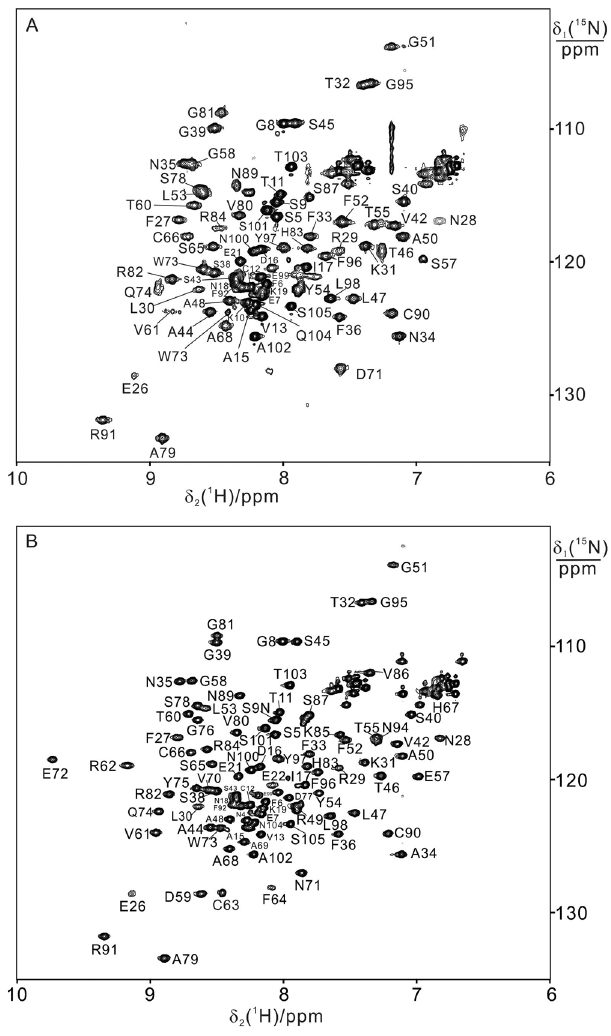
Figure 1. 15 N-HSQC spectra of BIR1 in solution. The NMR spectra were recorded for 0.3 mM WT BIR1 (1–105 aa) ( A ) and 0.3 mM D71N/R72E mutant of BIR1 ( B ) in 20 mM Bis-Tris buffer at pH 6.5 and 298 K with a proton frequency of 600 MHz. The cross-peaks with assignment were